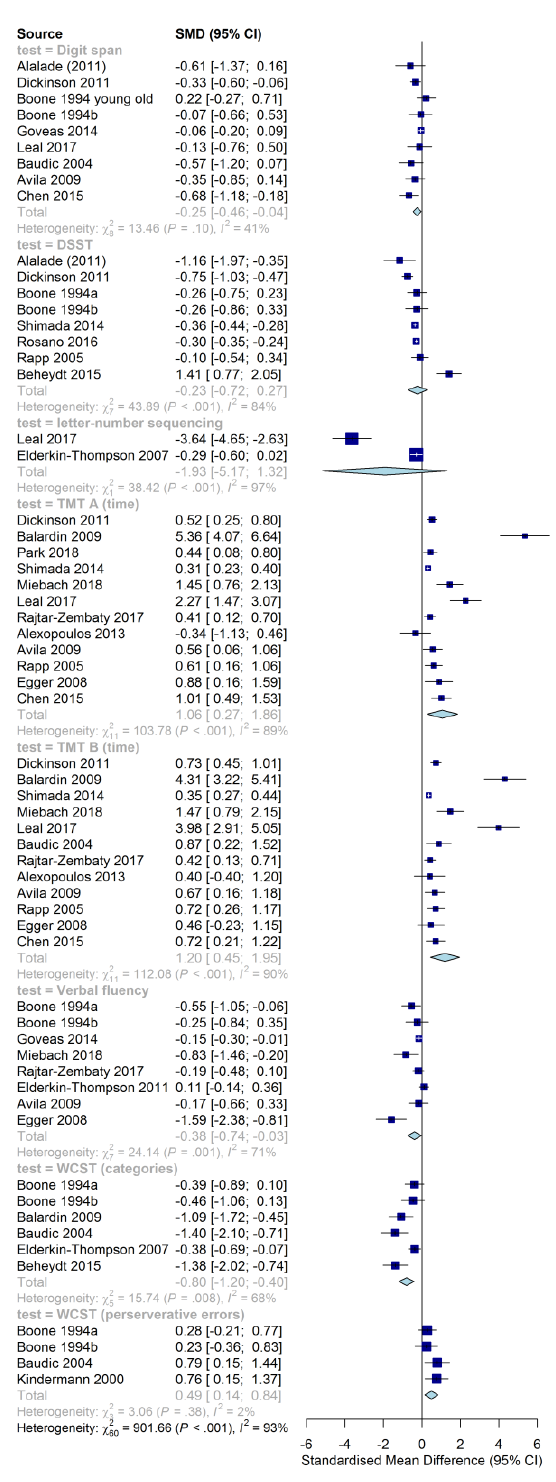
Figure 2. Forest plot for cognitive functioning in late-life depression showing individual and pooled effect sizes. A positive standardized mean difference indicates a higher average score for the depressed group. Every square in the forest plot represents a study. The bigger the square, the more it weighs in the pooled effect. The blue diamond represents the pooled effect size (expressed through the